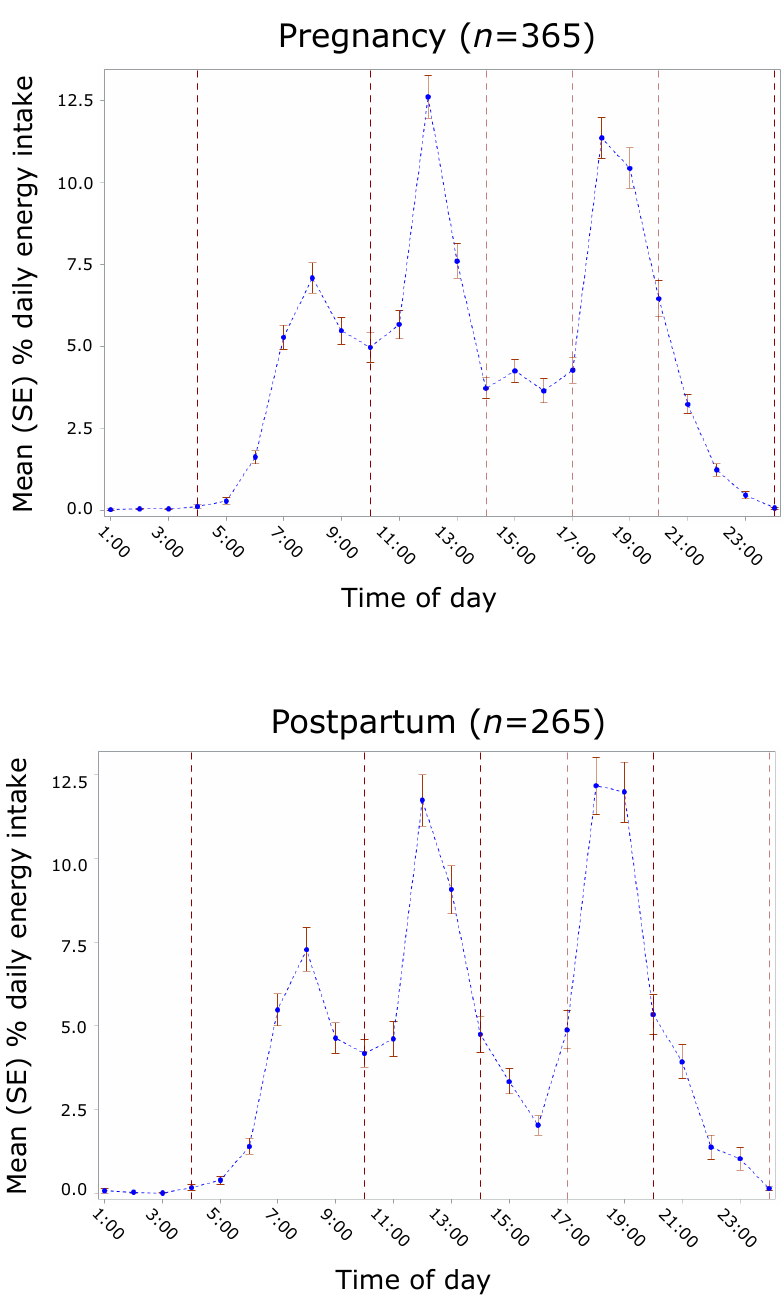
Figure 1. Intake timing in the Pregnancy Eating Attributes Study (PEAS) and time windows for PCA pattern identification. Blue dots with error bars show the mean percent daily energy intake at each hour with corresponding standard errors. Vertical dashed lines indicate the time windows used for PCA pattern identification based on the observed intake pattern by time of